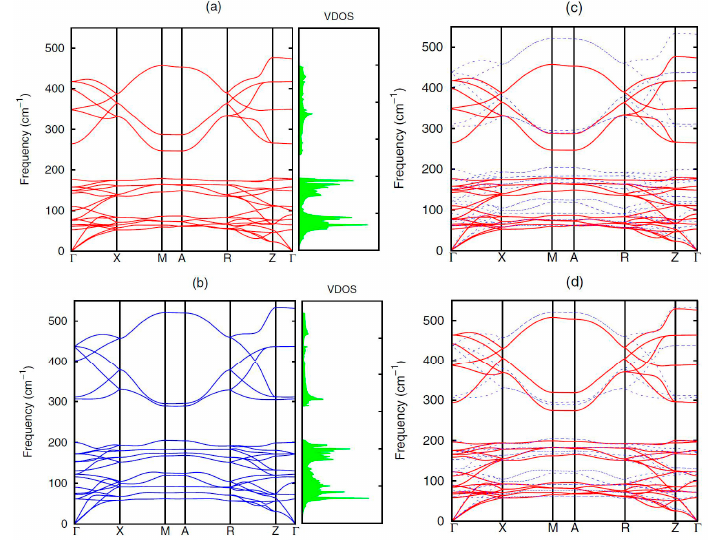
Figure 4. Red line and blue line in ( a , b ) represent the calculated phonon dispersion of BiCuSeO and LaCuSeO along the high-symmetry lines of the Brillouin zone; ( c ) Calculated phonon dispersion curves of BiCuSeO (red) and LaCuSeO (blue) for a direct comparison; ( d ) Red solid lines represent the normalized phonon dispersion data of BiCuSeO ( a ), while the blue dashed lines represent the calculated original phonon dispersion data of LaCuSeO. Reproduced with permission from Reference [47]. Copyright 2015, The American Physical Society.